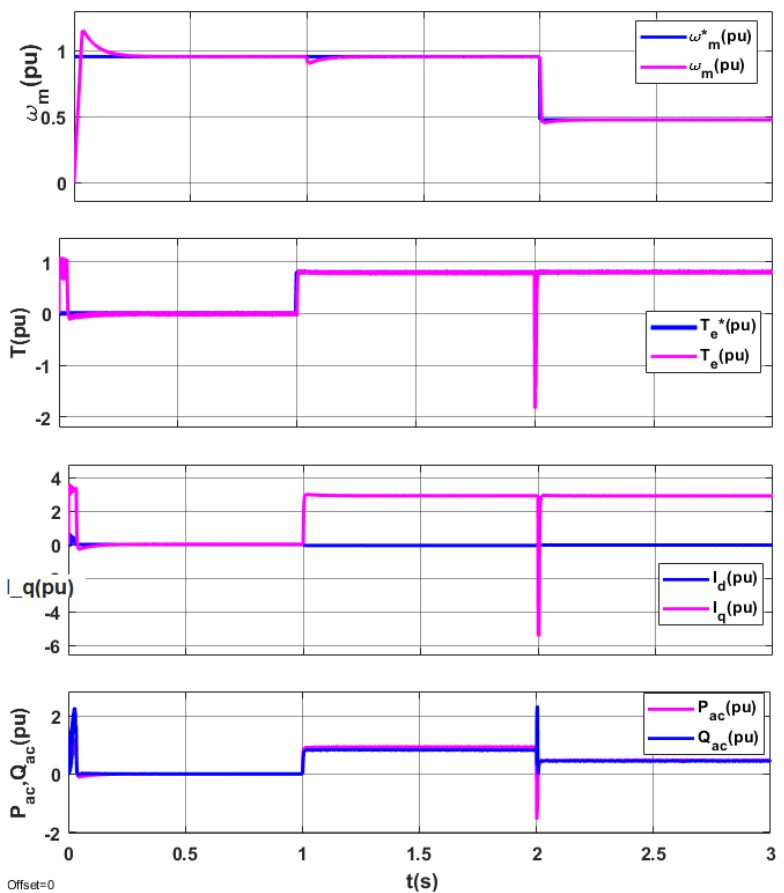
Figure 7. Energy processes (Pac, Qac) in inverter-PMSM drive system during speed and torque changes without energy optimization (FOC method).